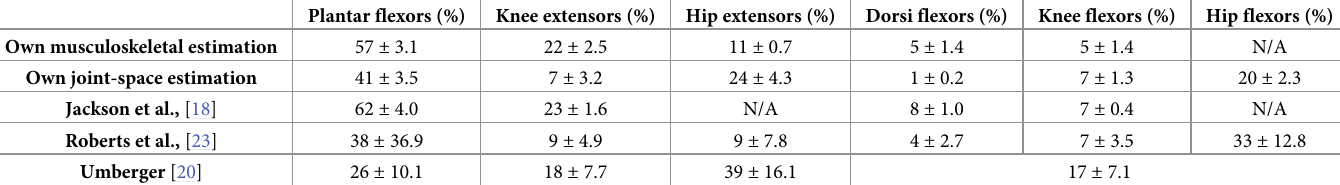
Table 4. Estimated metabolic rate (% mean ± s.e.m.) of different muscle groups during level walking in our own analyses and other studies. For the musculoskeletal estimation method, we grouped the metabolic costs of different functions similar to [20] as follows: soleus, gastrocnemius medialis and gastrocnemius lateralis for the plan- tarflexors, vastus medialis for the knee extensors, gluteus maximus for the hip extensors, tibialis anterior for the dorsiflexors, and biceps femoris for the knee flexors. For the joint-space estimation method, we partitioned the metabolic costs for the ankle plantar flexors/dorsiflexors, knee extensors/flexors, and hip extensors/flexors based on when the joint moments were in the corresponding direction. The metabolic rate of muscle groups in the normal walking condition from the study by Jackson et al., [18] was obtained by applying the modified Umberger [20] estimation code from [68]. The data from Roberts et al., [23] were obtained from their supplementary data file for walking at 70% of the preferred walking speed. We selected this trial from their supplementary data because the walking speed is most similar to the walking speed from our study (1 m � s -1 . We obtained the unilateral metabolic rate from the right ankle knee and hip joints by entering the data from the right ankle knee and hip as inputs to their MATLAB code and entering signals with zeros for all non-lower limb joints and all joints on the left side of the body. Plantar flexors (%) Knee extensors (%) Hip extensors